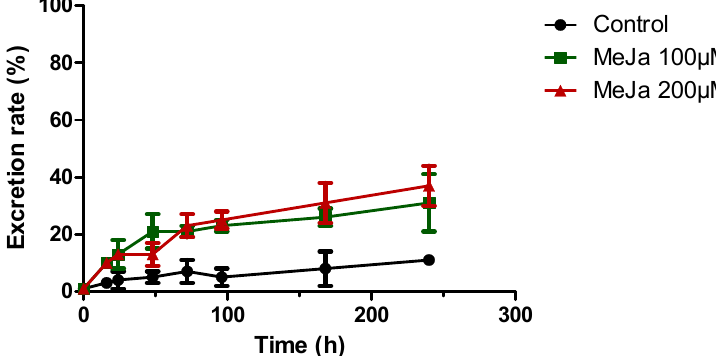
Figure 6. Proportion of stilbenes in the culture medium over time in control cultures ( ● ) and cultures treated with 100 µM ( ) or200 µM MeJA ( ). Each point represents the mean with standard deviation of three biological replicates.